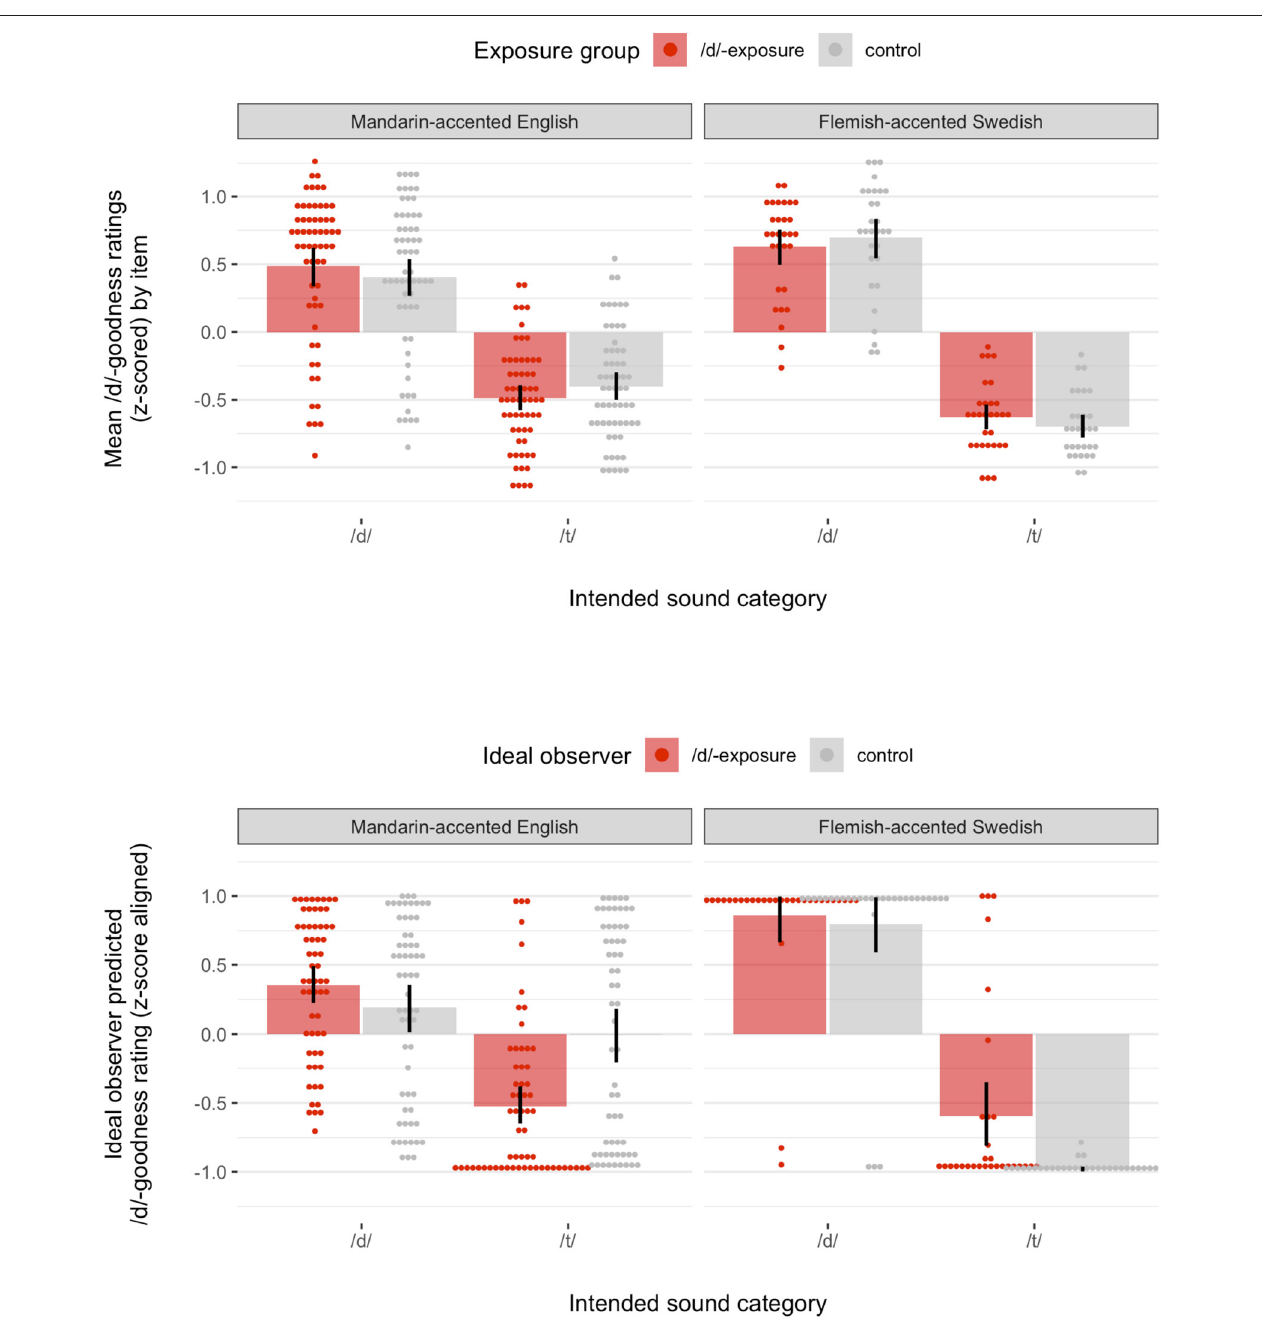
FIGURE 2 | (Top) Results of behavioral experiment on native listeners’ perception of syllable-final /d/ and /t/ in Mandarin-accented English (left) and Flemish-accented Swedish (right). Points show by-item means of z-scored /d/-goodness ratings (standardized within each participant) for non-native productions of syllable-final /d/ and /t/ during test, depending on the whether participants received exposure to the relevant non-native realization of syllable-final /d/ (/d/-exposure) or not (control). Bars show means and 95% bootstrapped confidence intervals of the by-item means. (Bottom) Ideal observer-predicted /d/-goodness ratings described in section 3.2.